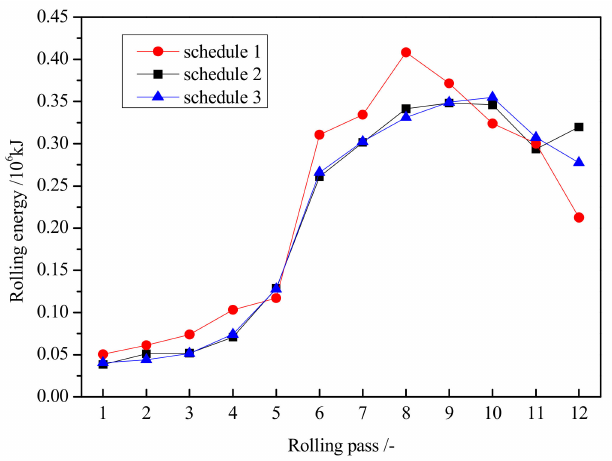
Figure 9. Comparison of rolling energy of each pass (tapping temperature 1180 ◦